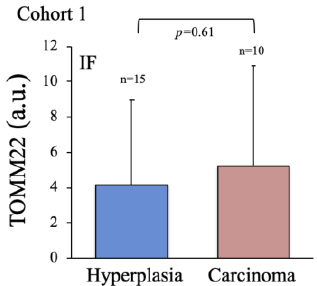
Figure A2. No significant differences in mitochondrial content between thyroid carcinoma and hyperplasia. Mitochondrial content was evaluated by immunofluorescence analysis of anti-TOMM22- labeled tissue samples. Data are mean ± standard deviation (SD).